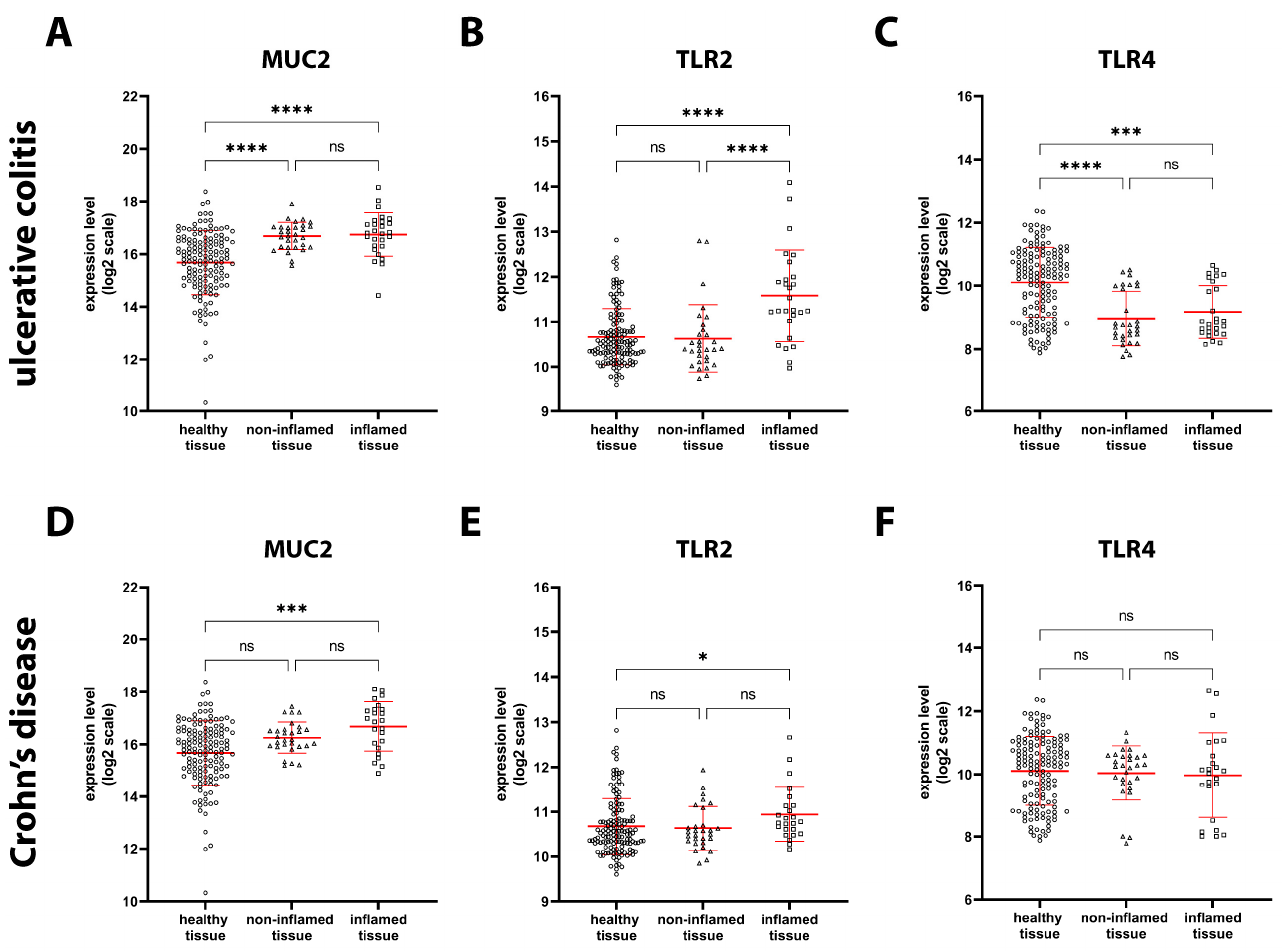
Figure 3. MUC2 , TLR2 , and TLR4 expression in healthy, UC, and CD tissue. MUC2 ( A ), TLR2 ( B ), and TLR4 ( C ) gene expression levels based on microarray data were compared among healthy tissue (circles, n = 142), as well as non-inflamed (triangles, n = 30) and inflamed (squares, n = 27) tissue from UC patients. MUC2 ( D ), TLR2 ( E ), and TLR4 ( F ) gene expression levels based on microarray data were compared between healthy tissue (circles, n = 142), as well as noninflamed (triangles, n = 29) and inflamed (squares, n = 24) tissue from CD patients. Data are shown by using a scatter plot, with each dot representing a single patient; values are shown in log2 scale and expressed as mean ± SD. p -values < 0.05 were considered statistically significant; p < 0.05 = *; p < 0.001 = ***; p < 0.0001 = ****. ns = non ‐ significant